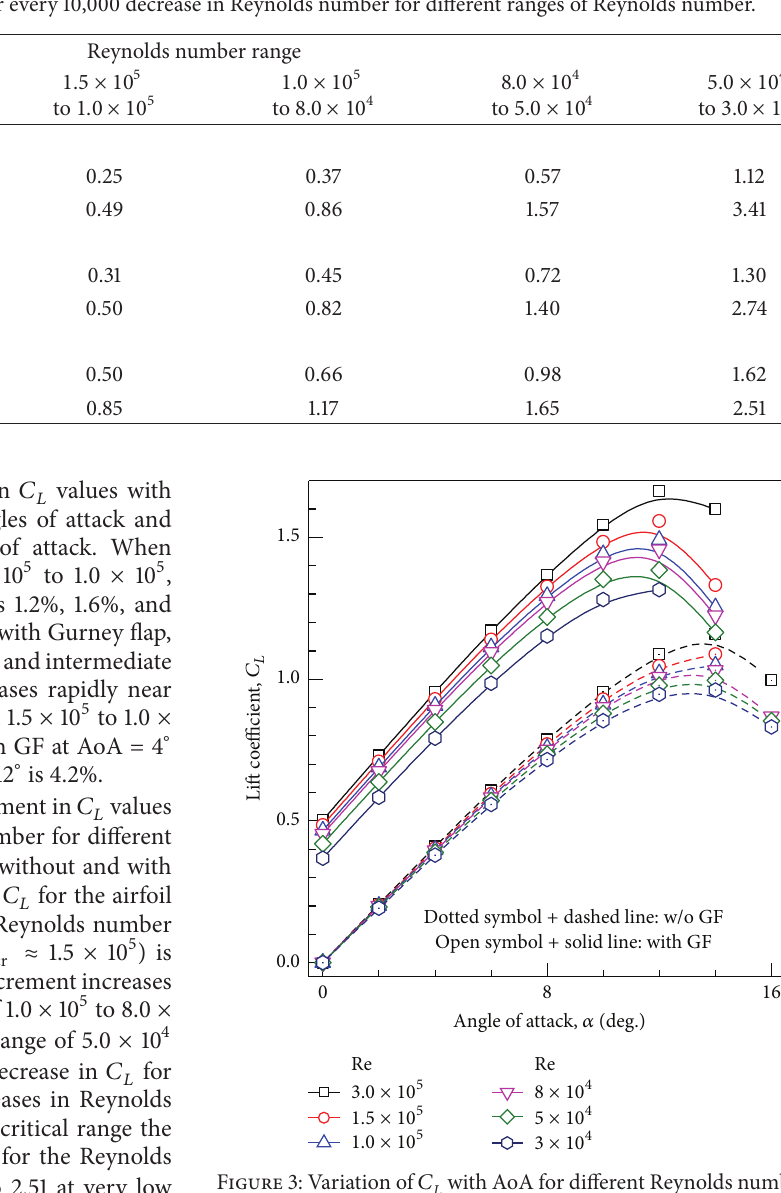
Table 3: Percentage Decrement in 𝐶 𝐿 per every 10,000 decrease in Reynolds number for different ranges of Reynolds number.